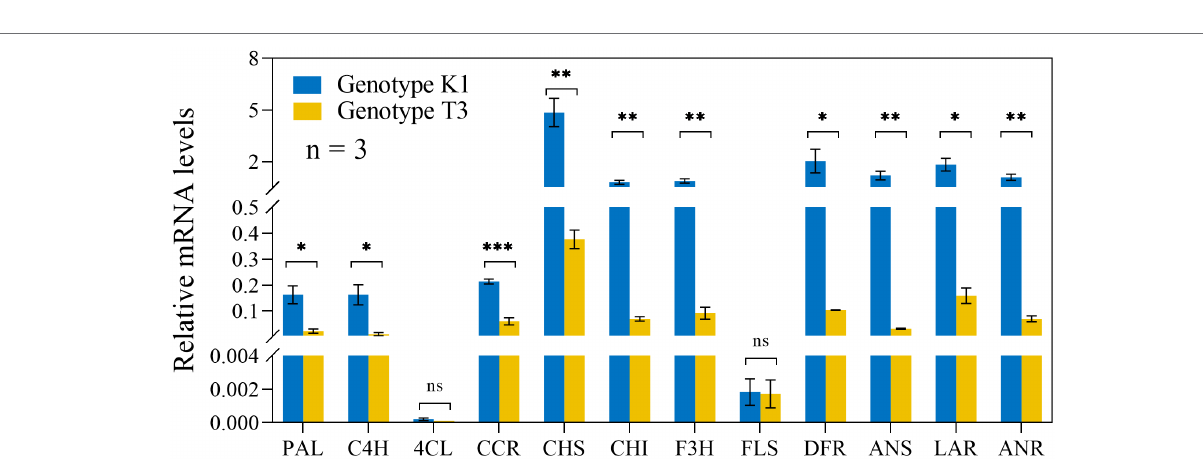
Frontiers in Plant Science | www.frontiersin.org